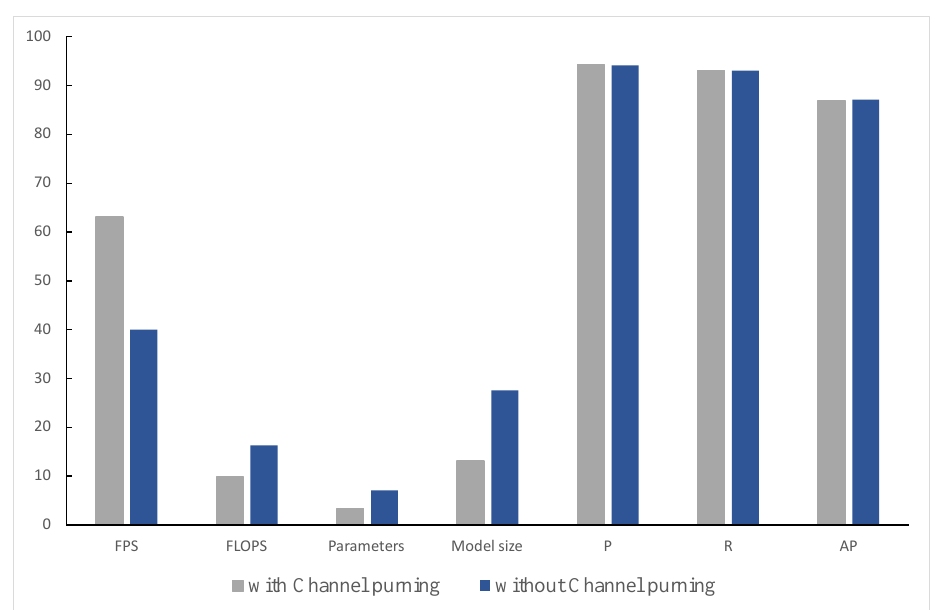
Figure 20. Performance comparison of the model with and without channel pruning.